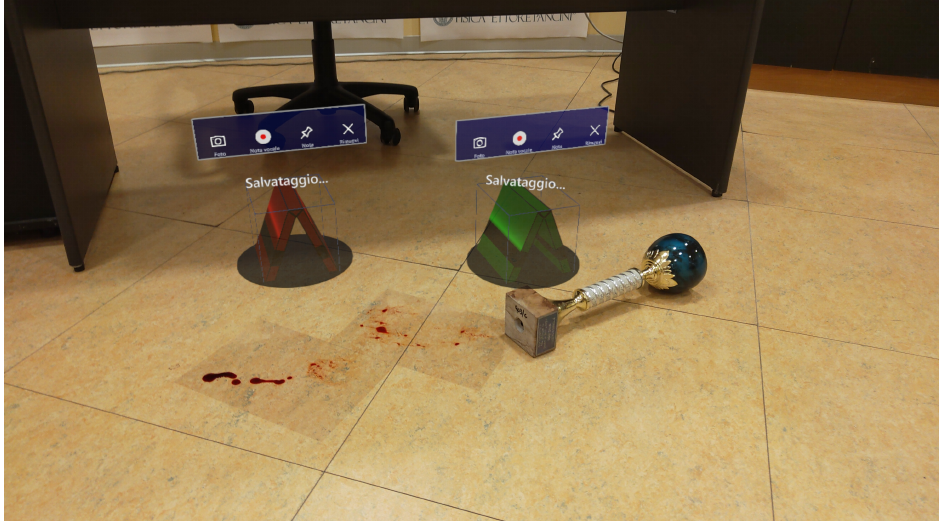
Figure 5. Examples of digital objects representing tags to be used to identify a trace at a crime scene (in the game session user mode).